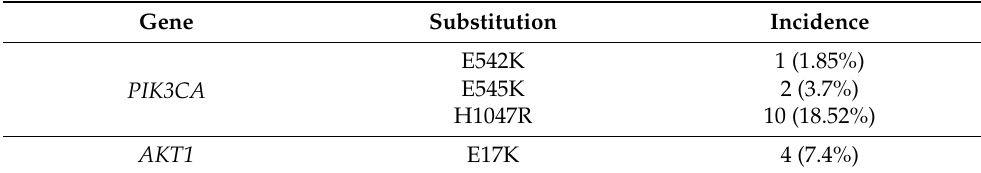
Table 1. Prevalence of mutations in all patients participating in the study. Gene